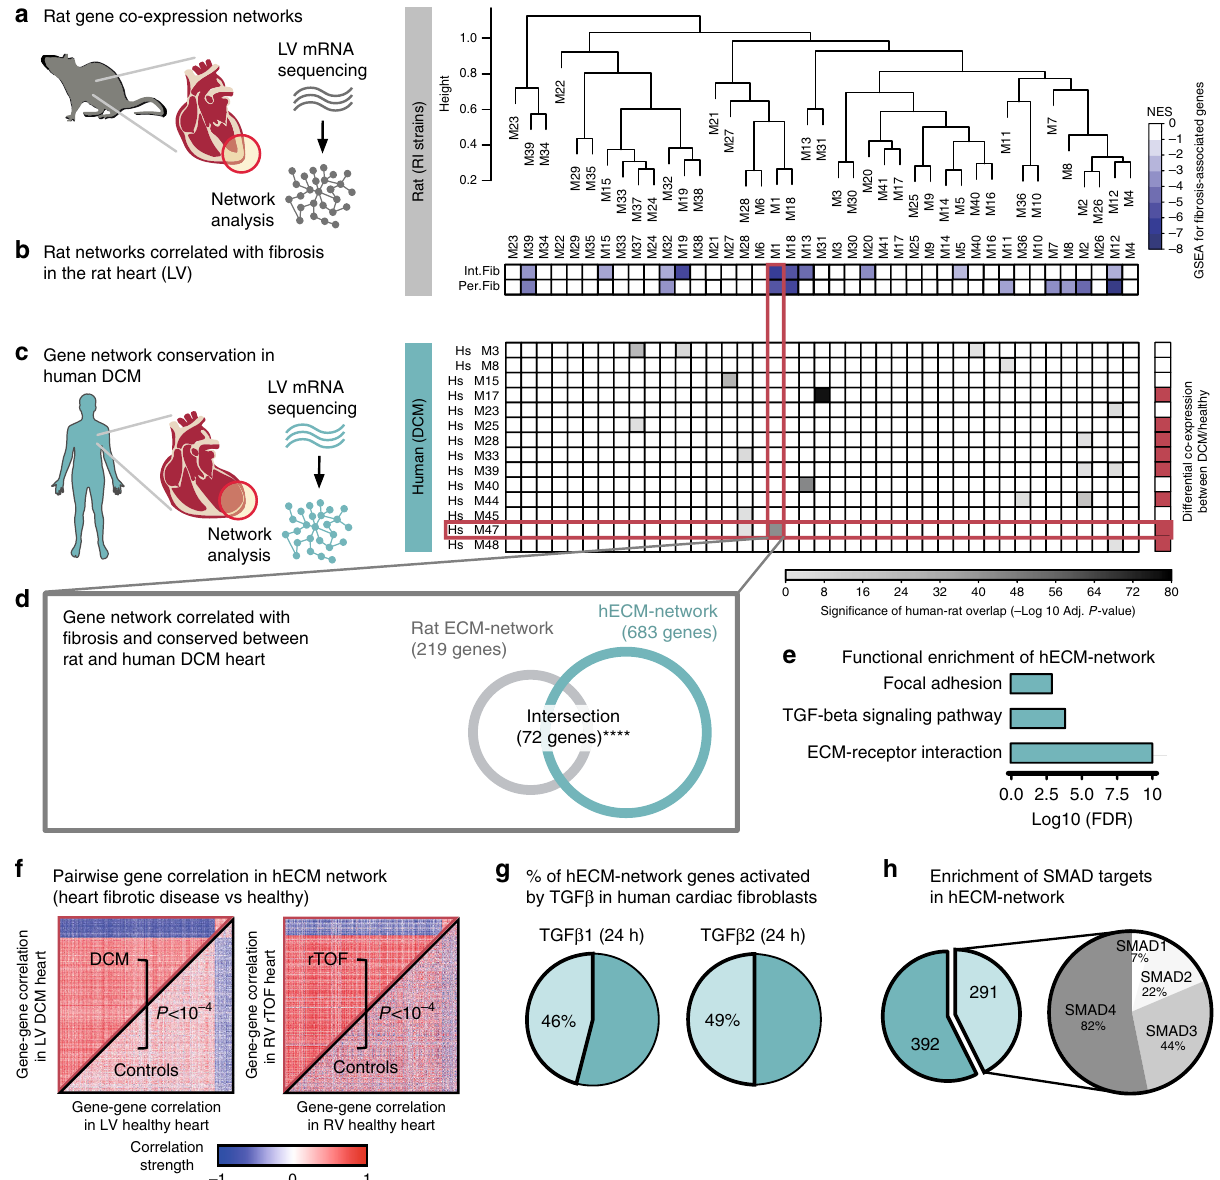
Fig. 1 Co-expression networks analysis in rats and humans identi fi es a disease-associated pro- fi brotic ECM transcriptional program. a Hierarchical clustering of the fi rst principal component of the rat co-expression networks (M1 to M39) inferred in the LV of the RI rat strains. Each branch denotes a distinct rat network with a different number of genes (full list in Supplementary Data 1a, b). b Level plot displaying the GSEA results with the signi fi cance of the association of each network to interstitial and perivascular fi brosis. This level plot is colored by GSEA NES, representing the strength of enrichment normalized by gene set size and white color denoting non-signi fi cant enrichment. c Each row represents a human co-expression network inferred in the LV of DCM patients. Only DCM networks that are signi fi cantly intersecting (adjusted P < 0.05, FET) to any rat network are shown (full list of networks in Supplementary Data 2a, b). The right panel highlights in red the human DCM modules that are signi fi cantly differentially co-expressed between DCM and control LV samples (red denotes adjusted P < 0.05, permutation test). d Shortlisted rat and human networks: rat network M1 (rat ECM-network) and human network Hs M47 (hECM-network). These two networks have a signi fi cant overlap and share 72 genes (adjusted P = 8.39 × 10 − 45 , FET). e Functional enrichment of the hECM-network shows signi fi cantly overrepresented terms (FDR < 0.05). f Heatmap of pairwise gene-gene expression correlation estimates of the 683 genes included in the hECM-network in: left, LV cohort (DCM patients, n = 126 and controls, n = 92) and right, RV cohort (rTOF patients, n = 27 and controls, n = 11). In both cases, patients are displayed in the upper-left triangular matrix whereas controls are displayed in bottom-right triangular matrix. The P is from the differential co-expression test (see Methods for details). g Percentage of genes in the hECM-network with signi fi cant differential expression (FDR < 0.05) in human ventricular cardiac (myo) fi broblasts after 24 h induction with either TGF β 1 or TGF β 2. h Breakdown of SMAD targets enrichment in hECM-network. The network contains 683 genes; 43% of these genes are targets of any SMAD (i.e., considering SMAD1/2/3/4; full list of SMADs targets in Supplementary Data